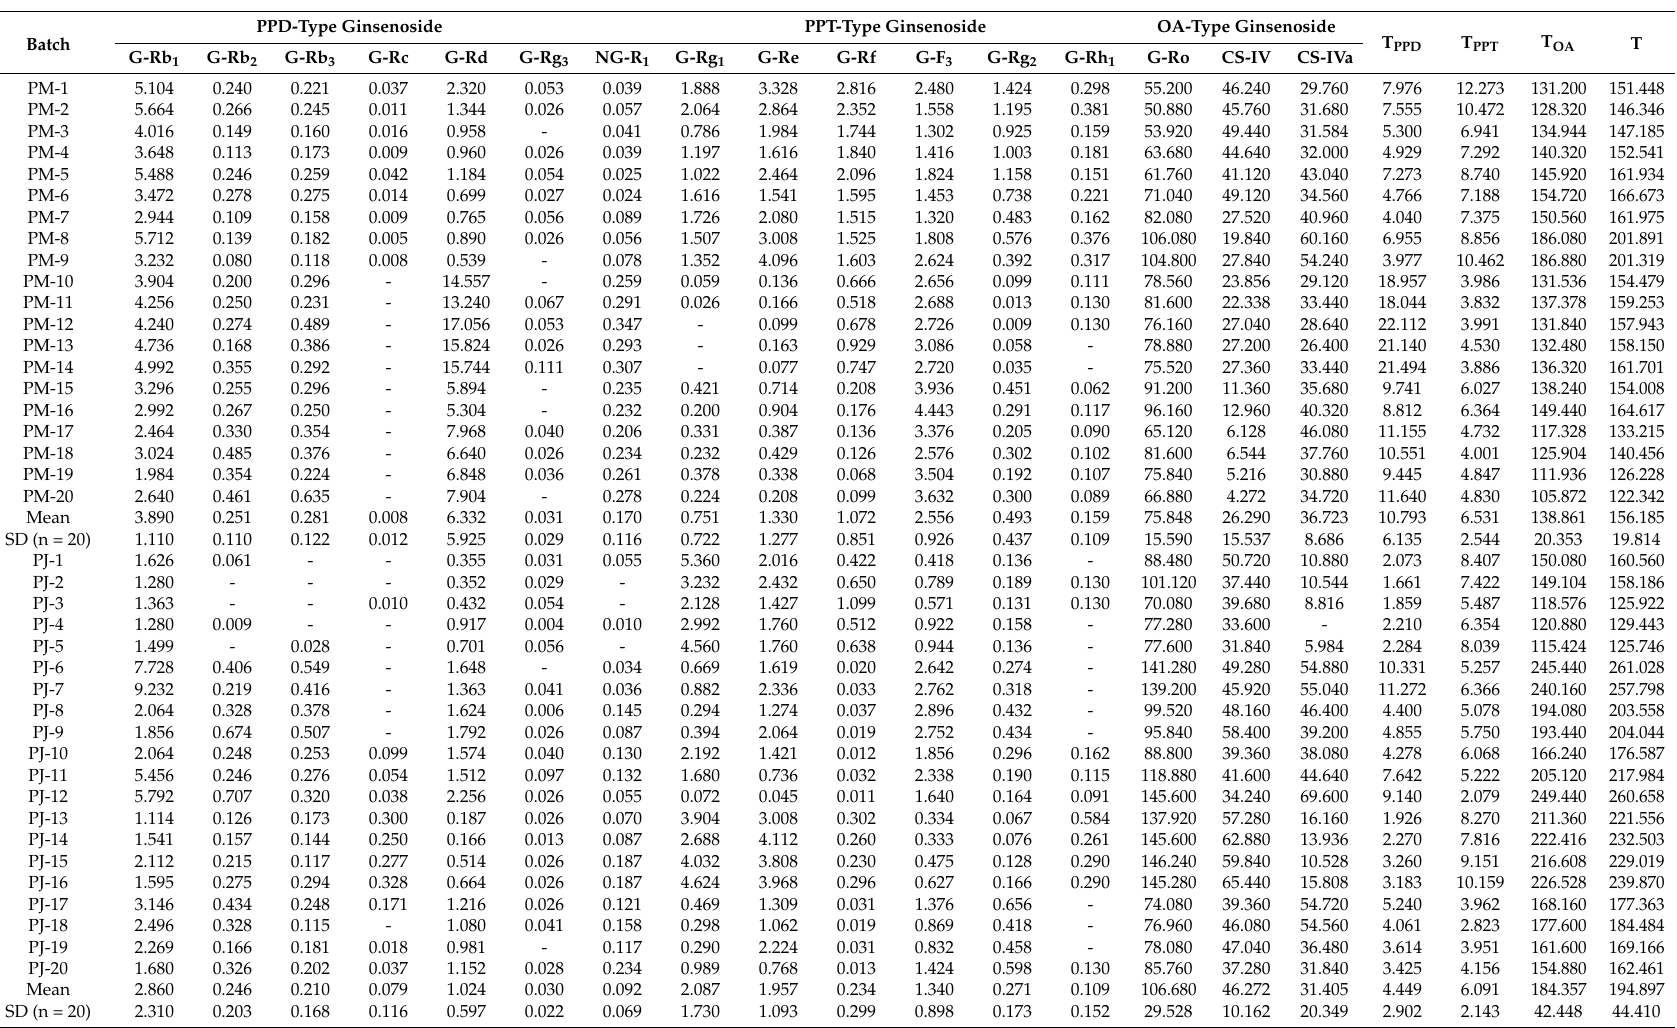
Table 6. The contents (mg × g − 1 ) of the 16 ginsenosides in the rhizomes of Panax japonicas (PJ), Panax japonicus var. major (PM), and Panax zingiberensis